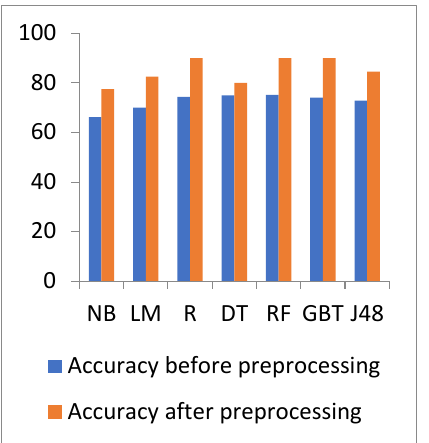
Figure 5. The SD values of heart disease data.